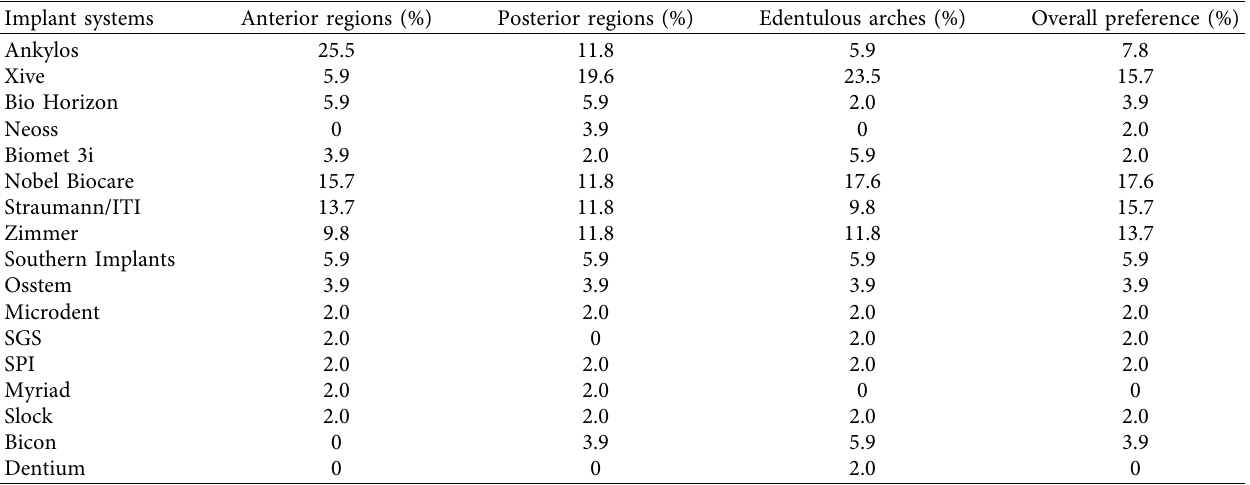
Table 2: Prosthodontists’ preferred implant systems.